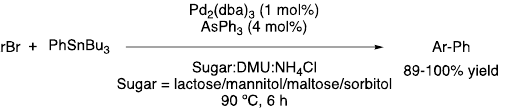
Figure 16. First example of a cross-coupling reaction in DESs.